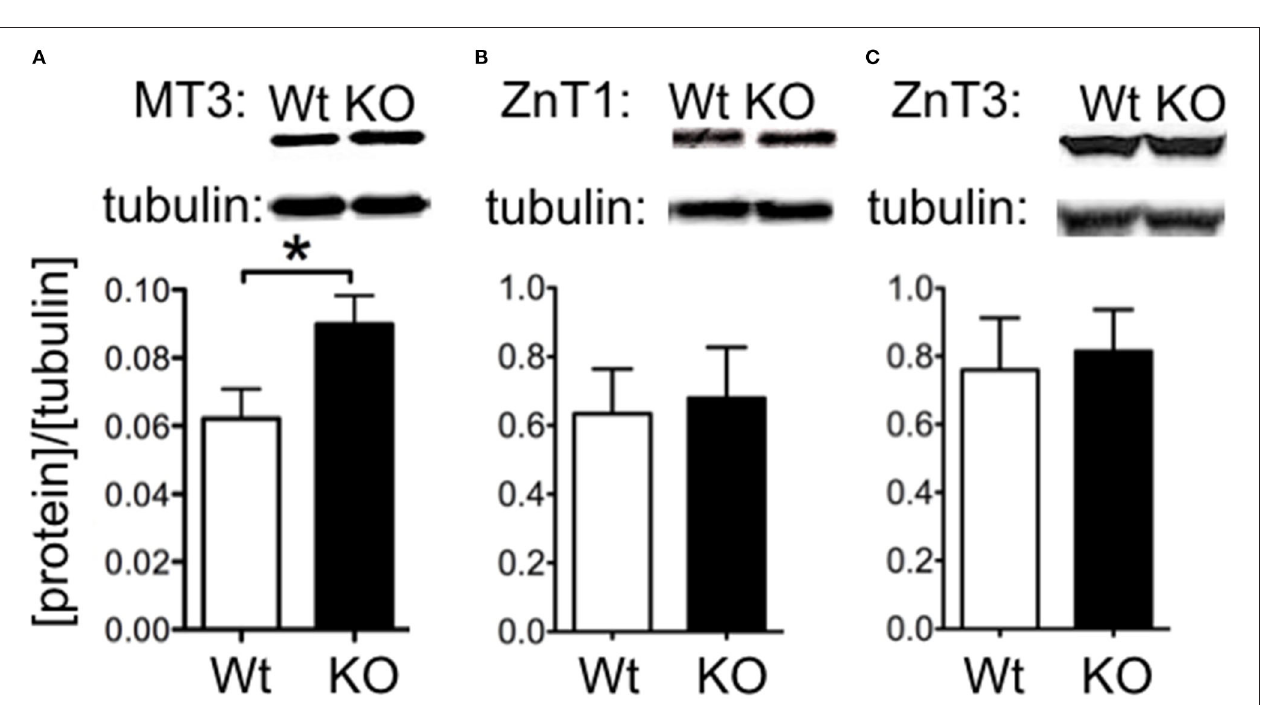
FIGURE 3 | Increased MT3 but not ZnT1 or ZnT3 protein levels in SELENOP1 KO hippocampus. Western blot showing expression levels of Zn 2 + transporter proteins, ZnT1 and ZnT3, and Zn 2 + storage pool, MT3. Protein densities were normalized to α -tubulin and averaged to male WT values. (A) ZnT1 protein levels